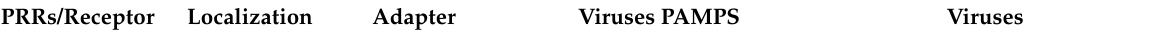
Table 2. Viruses recognized by Retinoic-acid inducible gene I like receptors or